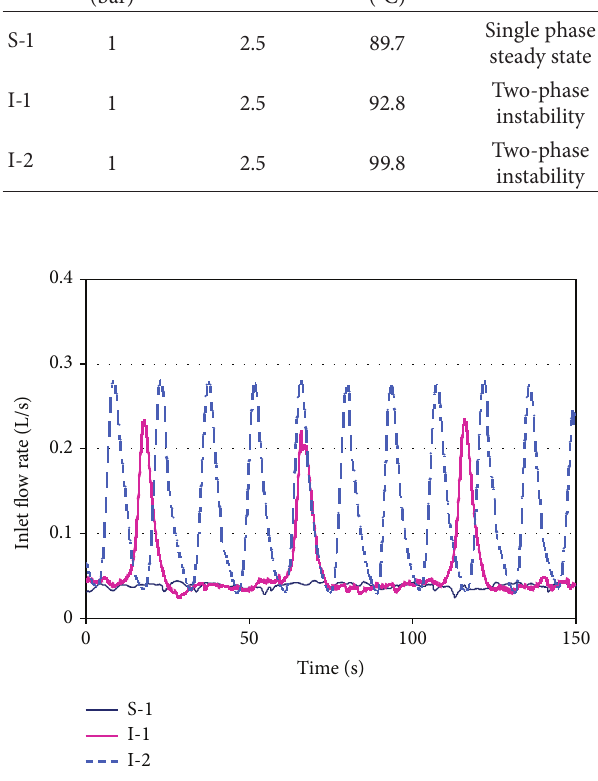
Figure 3: Inlet flow rate in the CIRCUS-IV single channel experi-